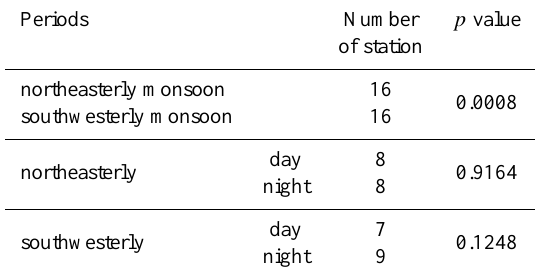
Table 1. Results of Mann–Whitney U test for seasonal and diurnal differences in larval fish abundance (CPUE) in the ECS,